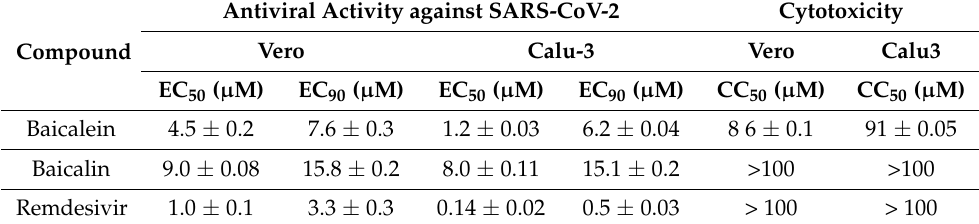
Table 1. Anti-SARS-CoV-2 activity and cytotoxicity of selected compounds. Anti-SARS-CoV-2 activity of each compound evaluated in Vero and human Calu-3 cells; the cytotoxicity was also determined in separate experiments.